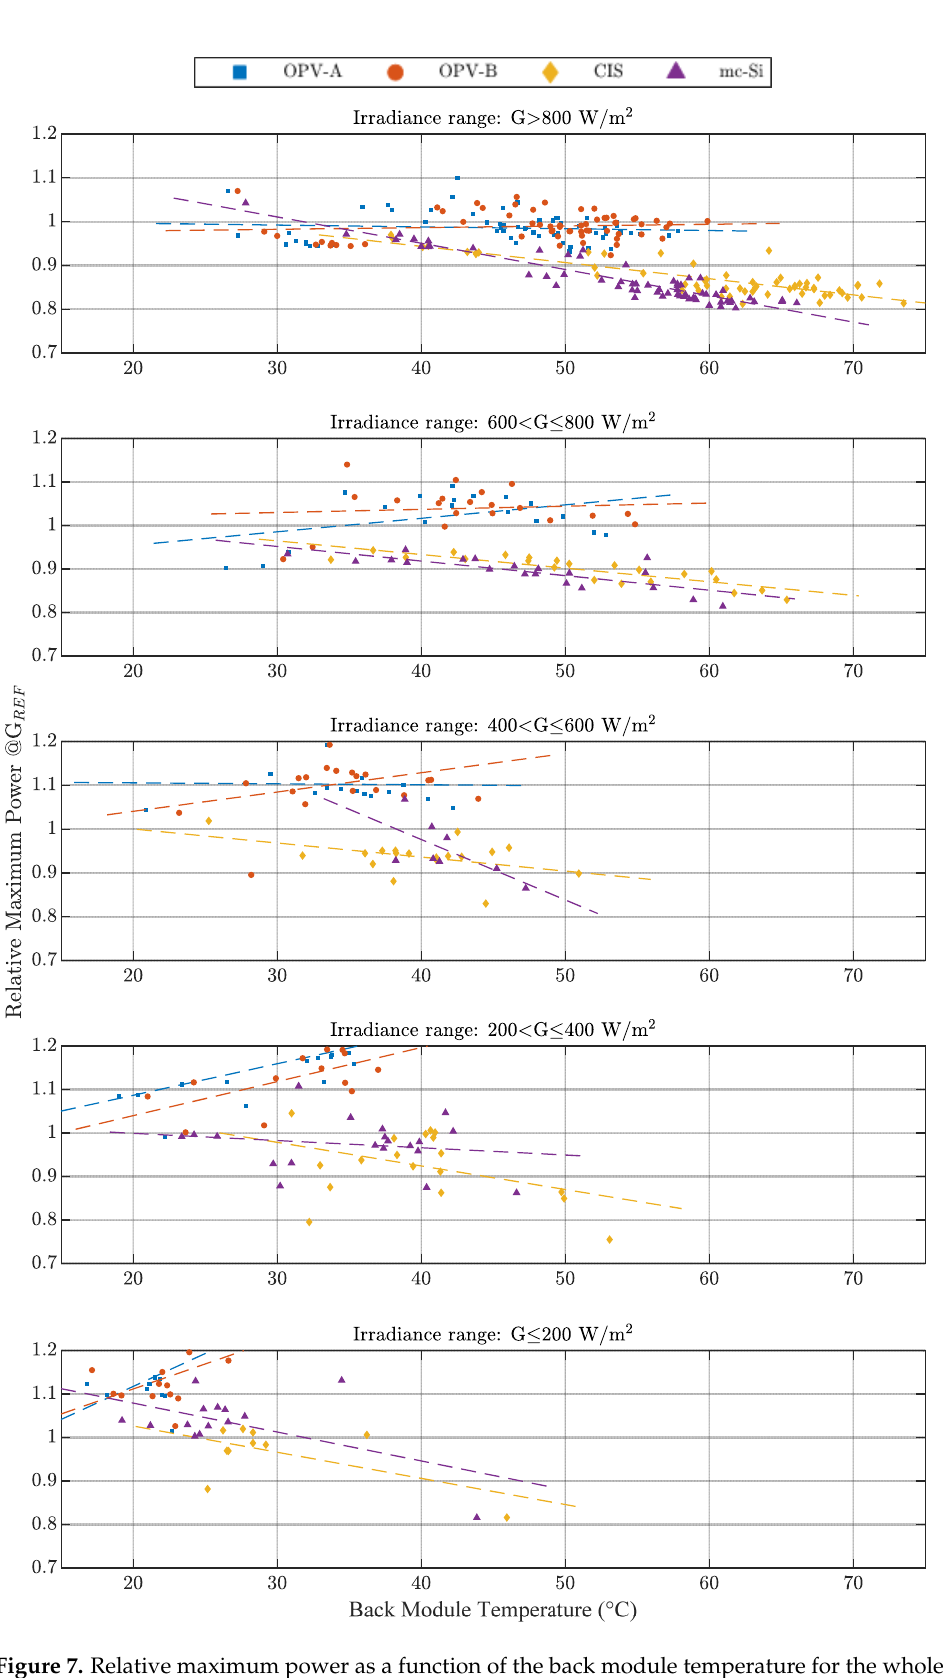
Figure 7. Relative maximum power as a function of the back module temperature for the whole set of PV modules under test.